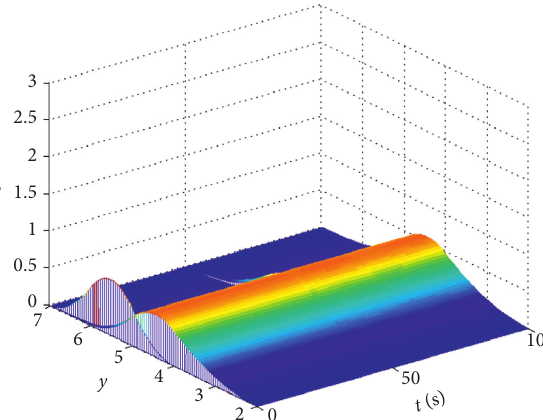
Figure 12: The output PDF with the proposed FTTC